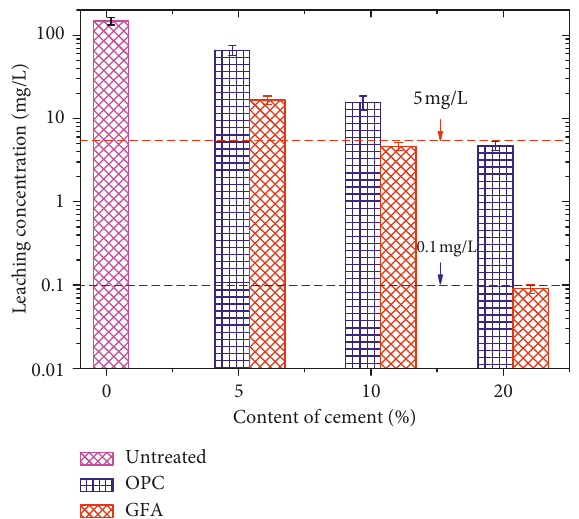
Figure 3: Pb concentration of the solidified/stabilized soils in the SPLP leachate.